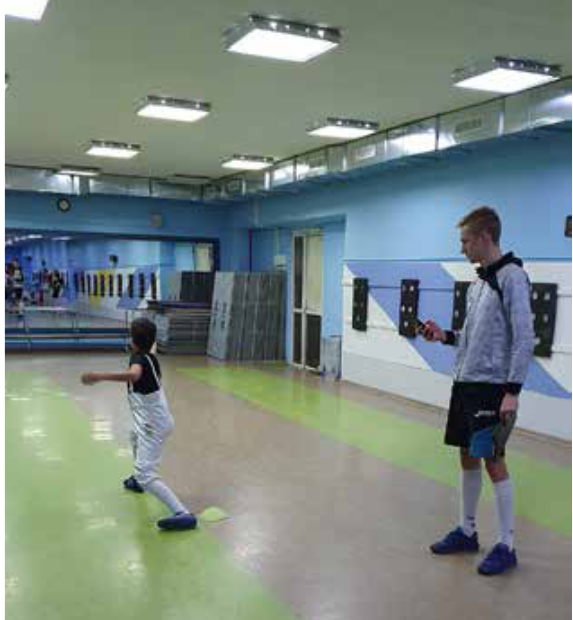
Figure 2. Test “Simulation exercises of simple combination, sec.” (photo - Irina Kriventsova) placed in front, behind, to the right and to the left at a distance of 2 meters on all sides of the